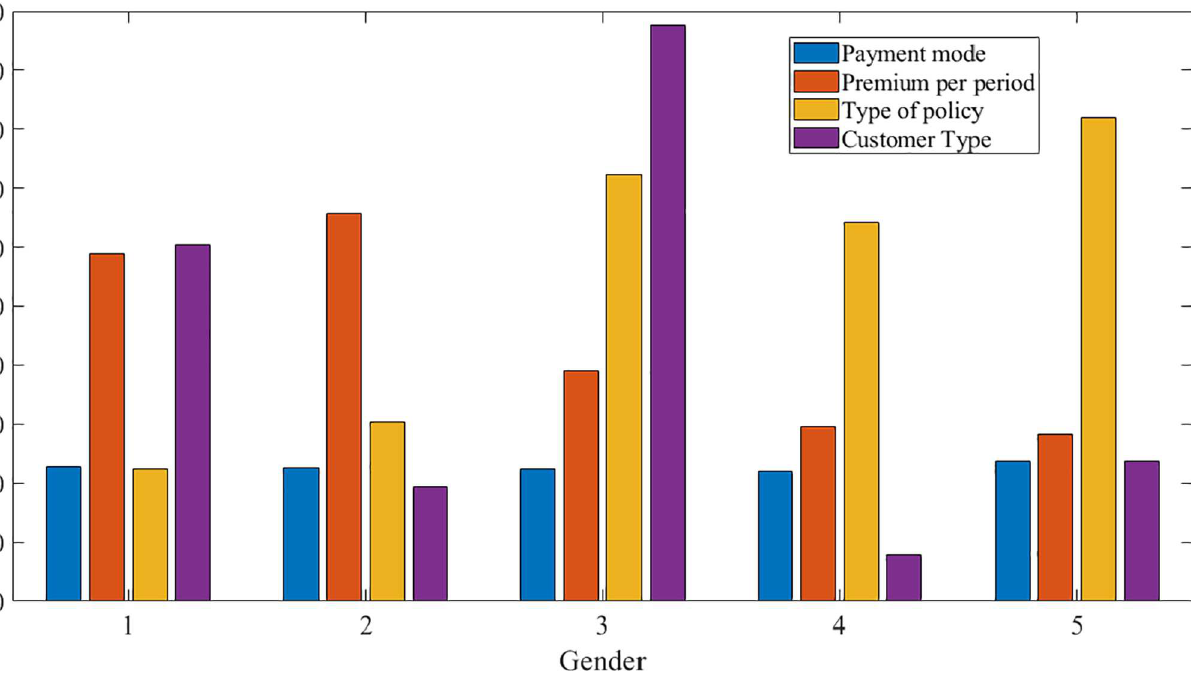
Fig 4. CART model data